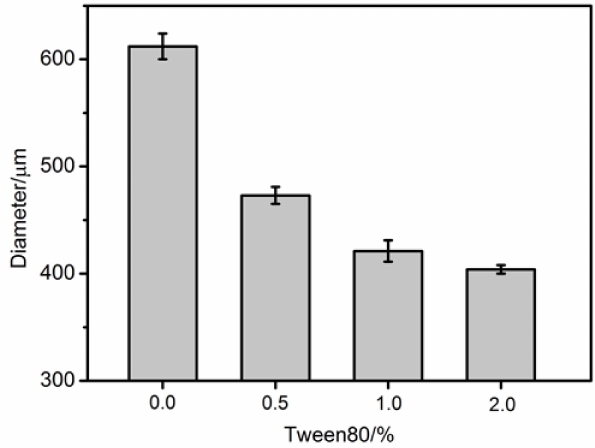
Figure 6. Size of microcapsules synthesized with different content Tween80 ( ϑ o : 3 mL · h − 1 , ϑ e : 5 mL · h − 1